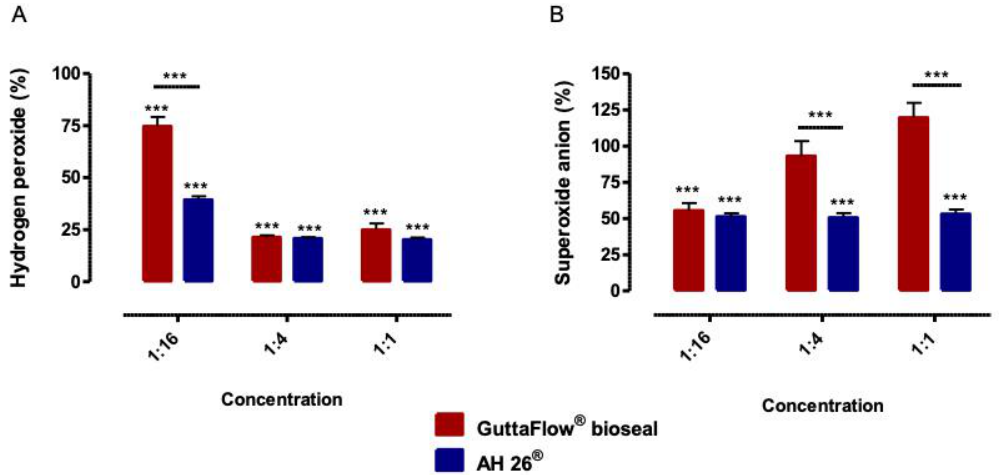
Figure 4. Intracellular production of hydrogen peroxide ( A ) and superoxide anion ( B ) of the MDPC- 23 cell cultures, after 24 h of incubation with the biomaterials conditioned media. The results are presented as the mean and standard error, with a minimum of six independent assays. Statistically significant differences to the control or between conditions are represented by a *, where *** means p <